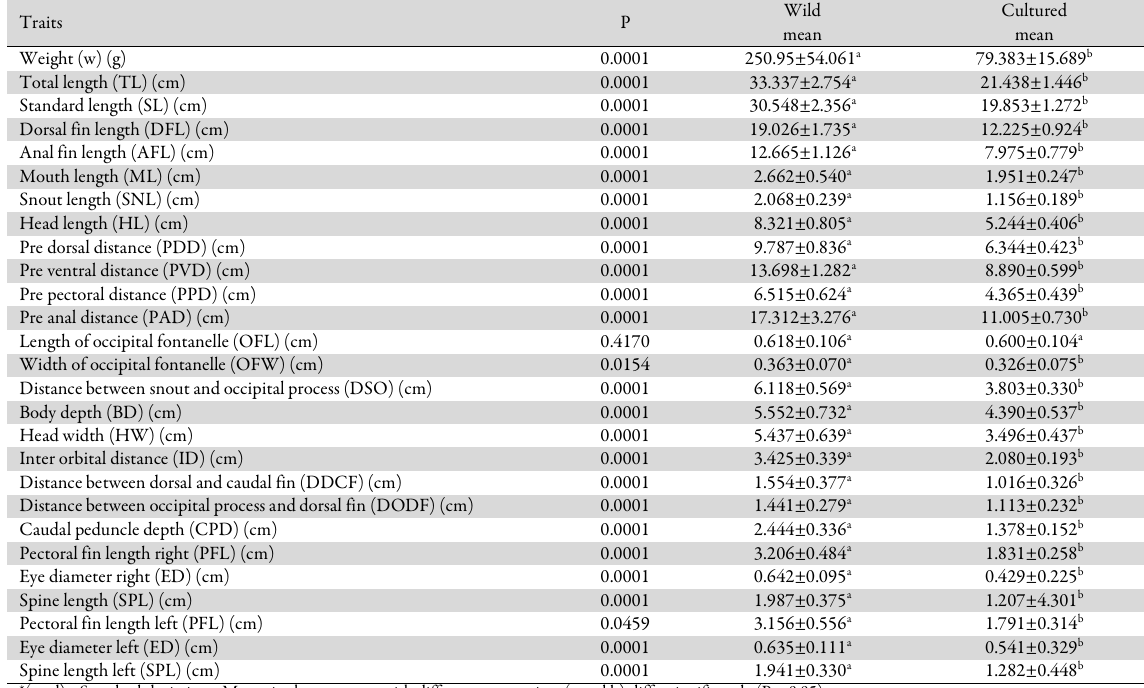
Table 1. The probabilities (P) and means of morphometrics of wild and cultured Clarias gariepinus from two populations in Ekiti State Traits